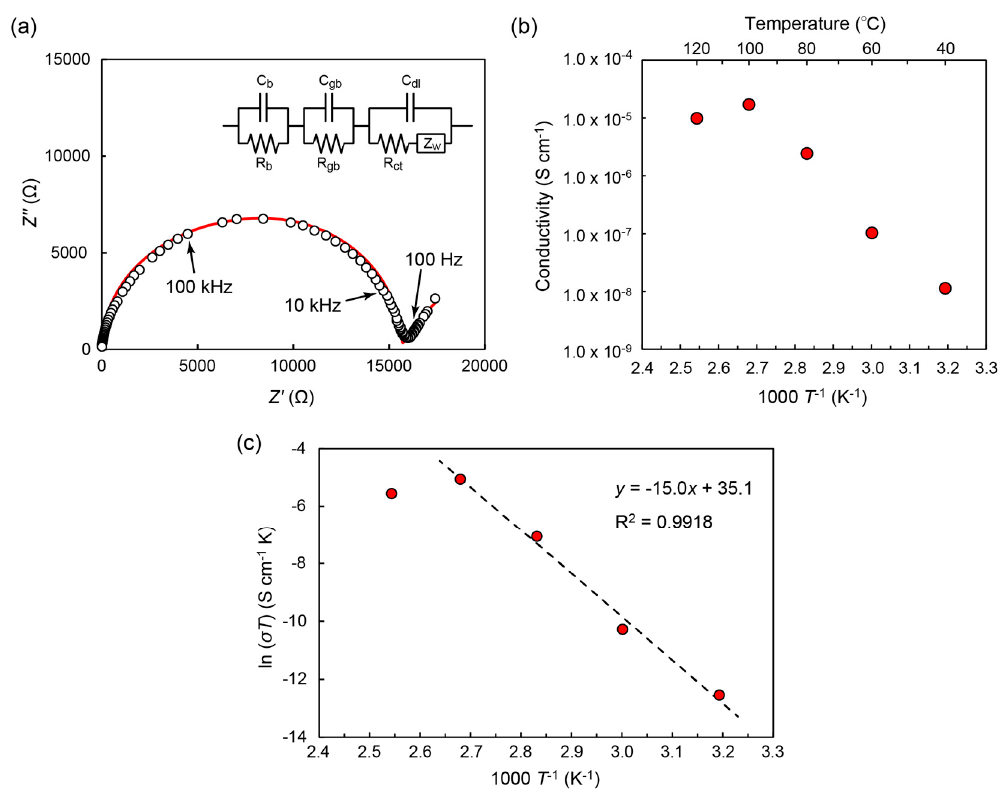
Figure 6. Conductive properties of the yellow C 12 pda-V 10 hybrids; ( a ) Nyquist spectrum (open circles) at 373 K and simulated spectrum (red line) based on an equivalent electronic circuit in the figure. The parameters obtained by the fitting: R b = 6.05 × 10 3 Ω , R gb = 9.65 × 10 3 Ω , R ct = 1.1 × 10 3 Ω , C b = 2.5 × 10 − 8 F, C gb = 5.0 × 10 − 8 F, C dl = 2.0 × 10 − 4 F, σ = 2.0 × 10 3 Ω s − 1/2 ( Z w = (1 − j ) σ /( ω − 1/2 )); ( b ) temperature dependence of the conductivity; ( c ) Arrhenius plot of the conductivity. Least-squares fit is shown as a broken line. The fitted results are in the figure.